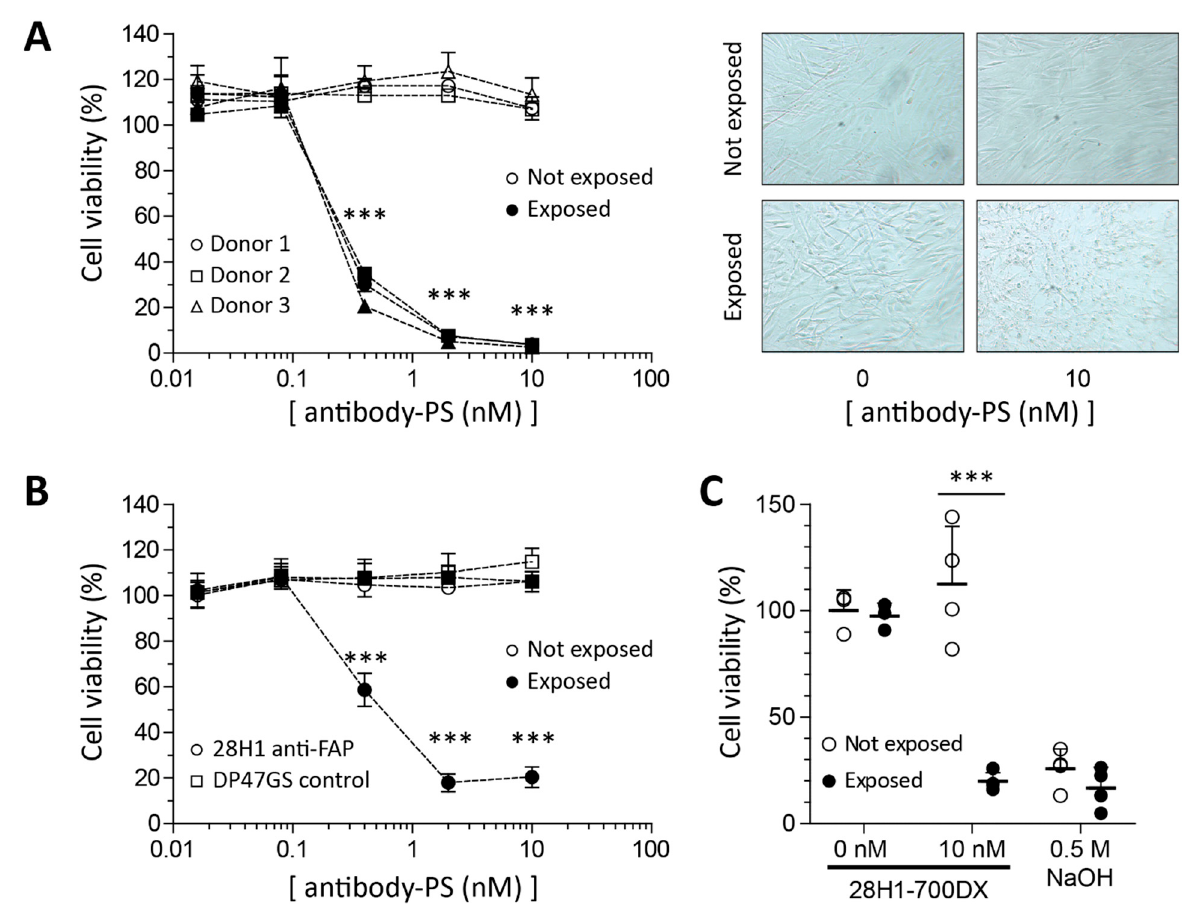
Figure 2. Application of FAP-tPDT in monolayer culture of primary lesional SSc skin fibroblasts. In three fibroblast cell strains, a dose range of PS-FAP antibody construct was applied and cell viability was measured using CTG after exposure to light and compared to cells not exposed to light. The PS-FAP antibody construct dose-dependently killed fibroblasts with a LD 50 of approximately 0.25 nM but only in cells exposed to light ( A ). Application of a PS-non-targeting antibody (DP47GS) construct had no effect on fibroblast viability ( B ). ( n = 4 replicates per donor). Cell viability decreases after FAP-tPDT as measured by the MTT assay. Cells were incubated with 0 or 10 nM 28H1-700DX or 0.5 M NaOH. No cell death was observed in the cells not exposed to light or not incubated with the antibody. Results are depicted as mean with SD ( n = 4 or n = 3 for cells not incubated with the antibody (0 nM)) ( C ). ***= p <0.001.